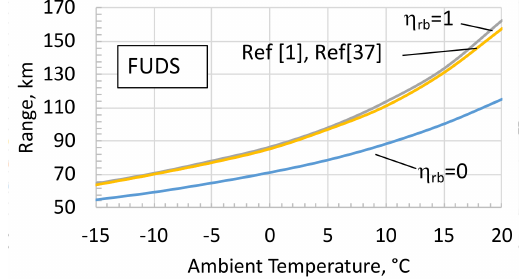
Figure 8. Impact of different regenerative braking assumptions on range in the case of FUDS driving